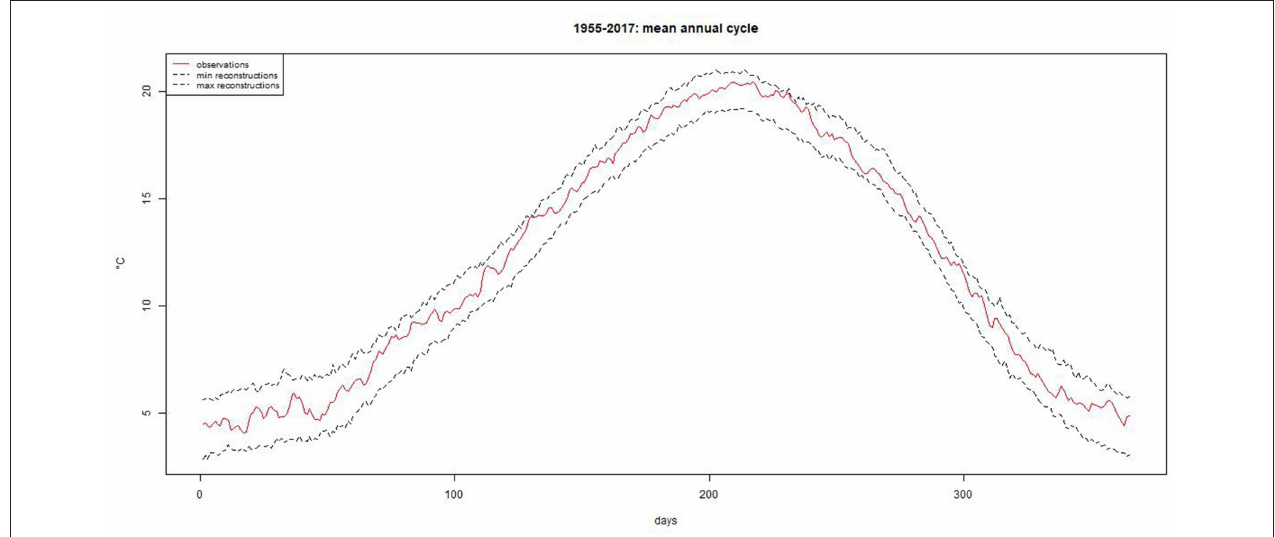
FIGURE 5 | Observed mean annual cycle in the total period 1955–2017 (red line) compared to the envelope of the mean annual cycles in the same period from the reconstructions (dotted lines).